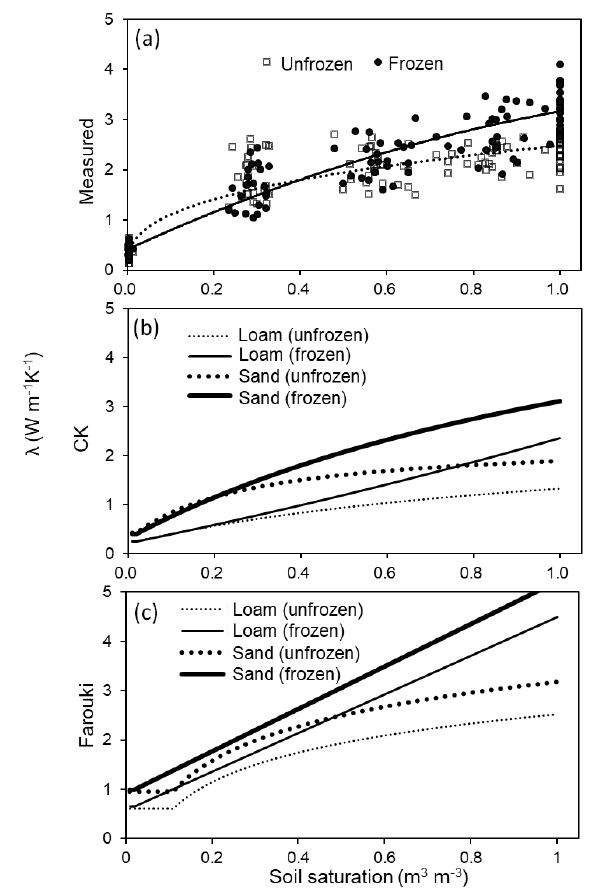
Figure 4. The relationship between soil saturation (solid and dotted lines represent frozen and unfrozen cases) and soil thermal con- ductivity ( λ , Wm − 1 K − 1 ) from (a) measured values (measured; dots and empty diamonds represent measured frozen and unfrozen soil thermal conductivities), (b) using the Côté and Konrad (2005) scheme (CK) and (c) using the Farouki (1986) scheme (Farouki).